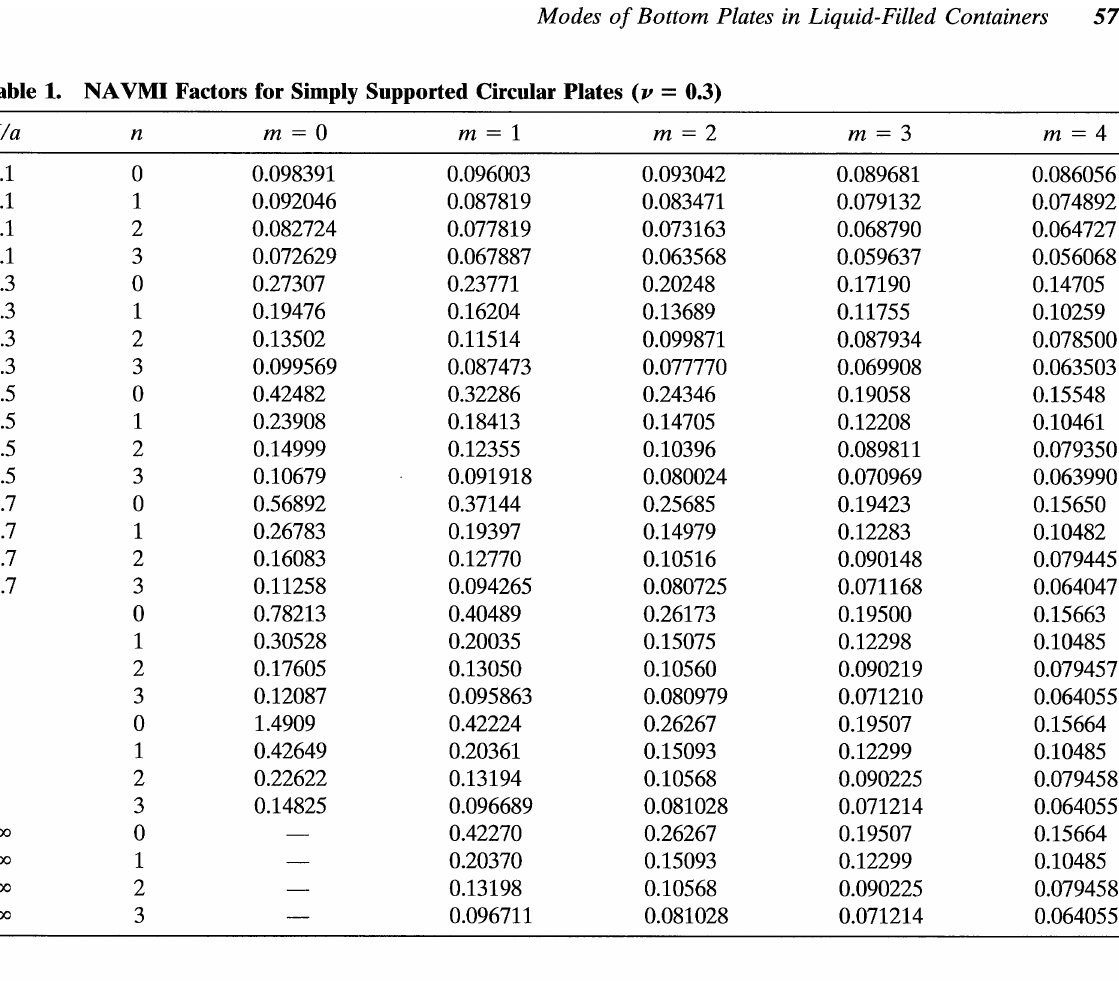
Table 1. NA VMI Factors for Simply Supported Circular Plates (v = 0.3)